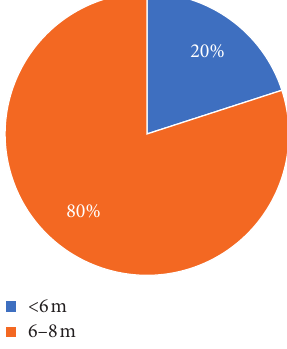
Figure 5: Height of the columns.